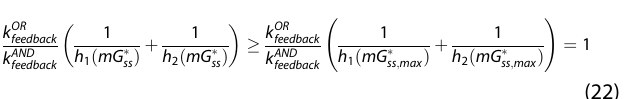
The left-hand side can be rewritten as k OR feedback ð h 1 ð mG (cid:1) ss Þþ h 2 ð mG (cid:1) ss ÞÞ